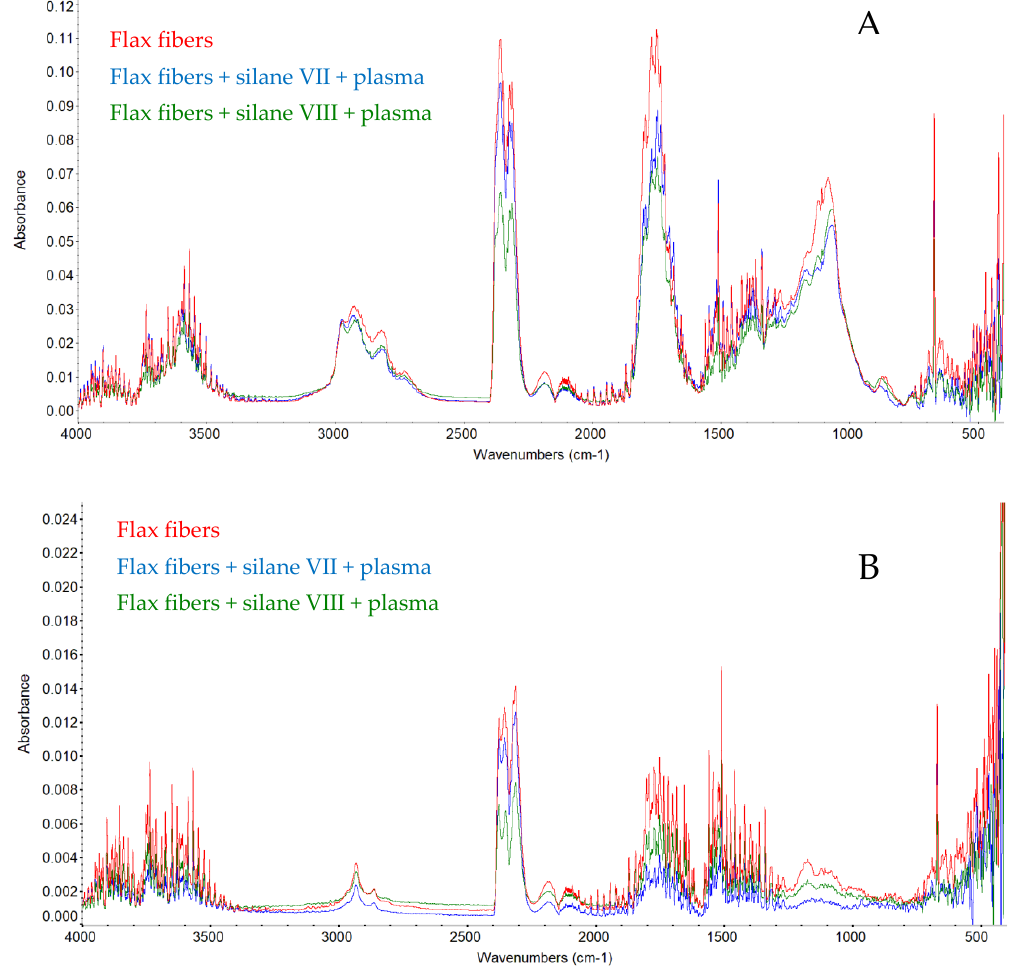
Figure 2. FTIR spectra for III rd step ( A ) and II nd step ( B ) of thermal decomposition unmodified and modified fibers.